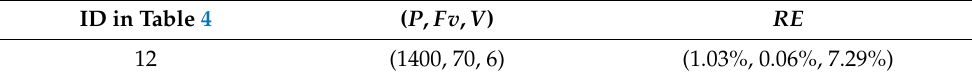
Figure 6. Pareto front of MOSMA-SVR-POLC (3D and 2D). Table 5. Optimal process parameters and relative errors ( RE ) of